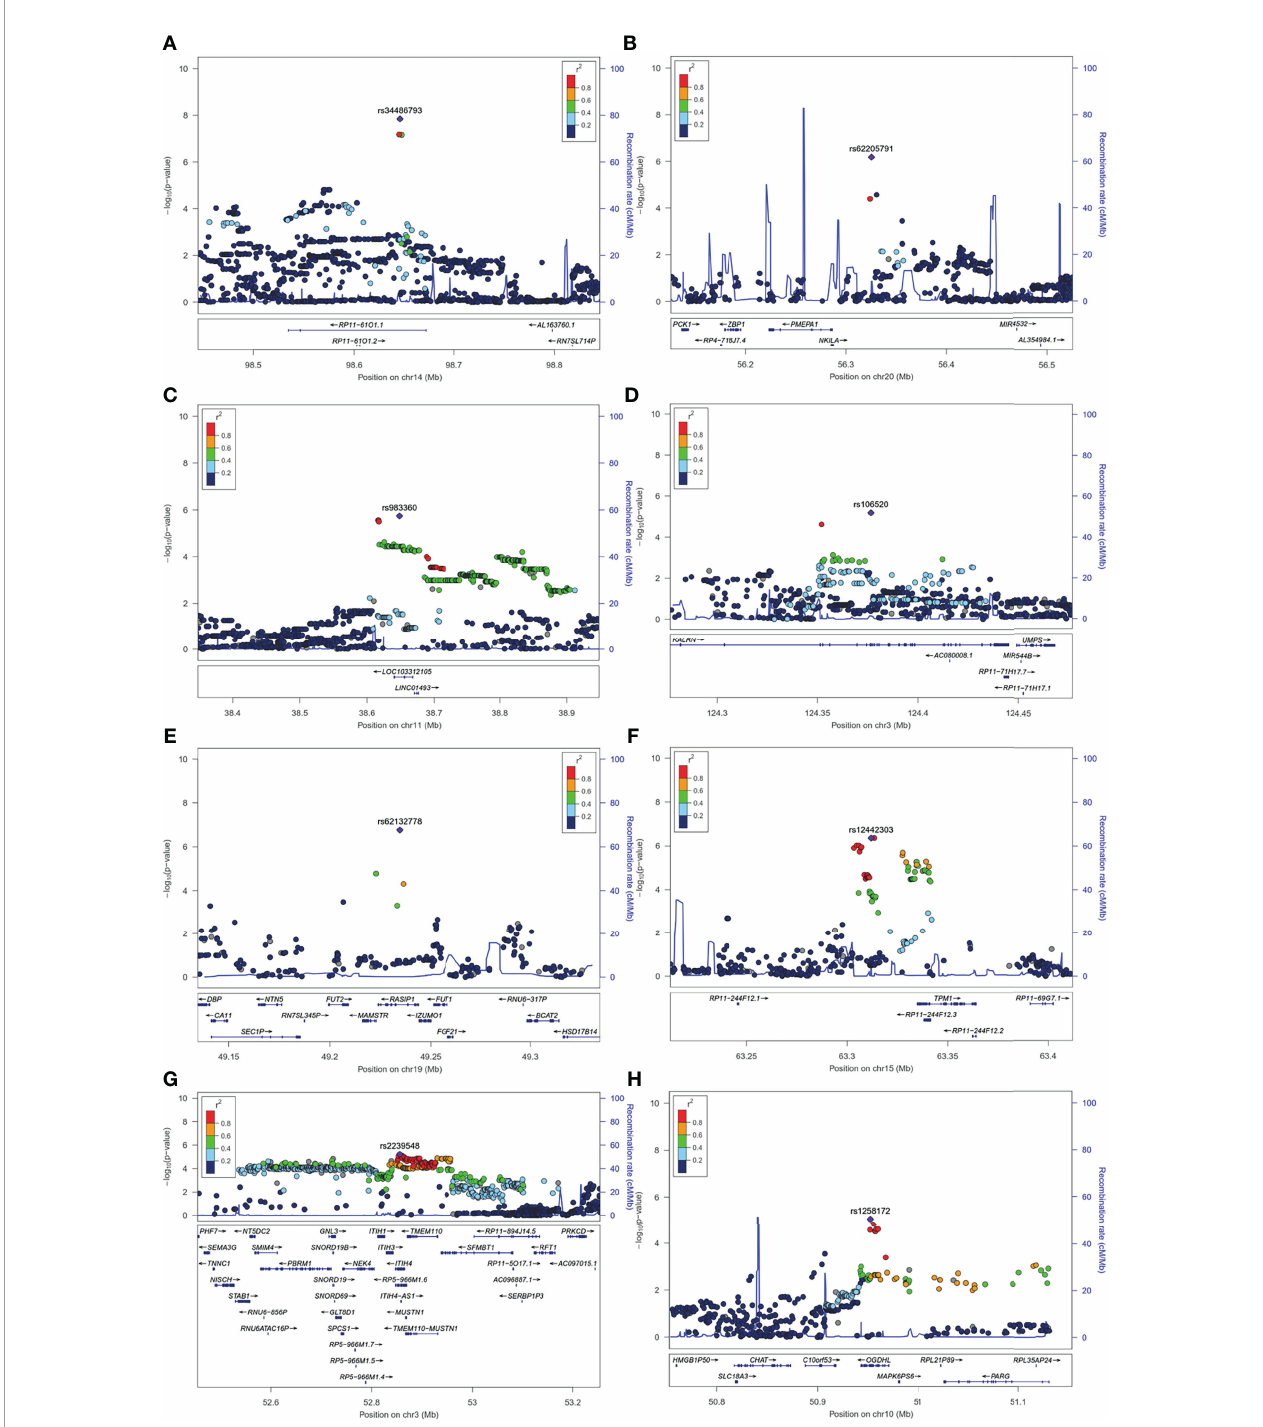
FIGURE 2 | Regional plots for novel association loci. The x-axis represents the chromosomal position, and the y axis is the – log10 of the P value of association. The index SNPs are shown as purple diamonds. Colors indicate the LD level with the index SNP. Red signi fi es r 2 ≥ 0.8, with orange 0.6 ≤ r 2 <0.8, green 0.4 ≤ r 2 <0.6, light blue 0.2 ≤ r 2 <0.4, and dark blue r 2 <0.2. Blue lines represent recombination hotspots estimated in the East Asian population (from the 1000 Genomes Project, November, 2014). Genomic positions are based on human genome assembly hg19. The plot shows the names and locations of the genes; the transcribed strand is indicated with an arrow. Index SNPs (A) rs34486793 at 14q32.2. (B) rs62205791 at 20q13.31. (C) rs983360 at 11p12. (D) rs106520 at 3q21.1. (E) rs62132778 at 19q13.33. (F) rs12442303 at 15q22.2. (G) rs2239548 at 3p21.1. (H) rs1258172 at